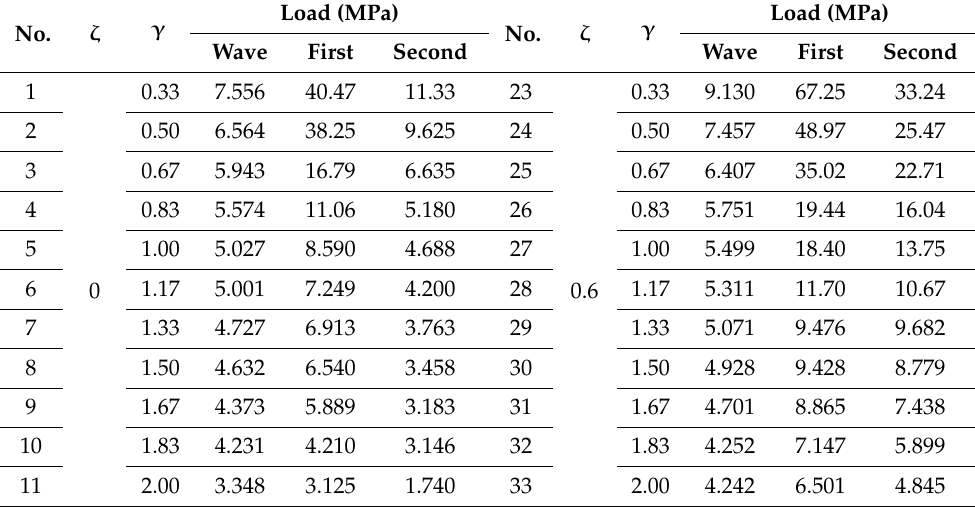
Table A1. Pressure load under different ζ and γ